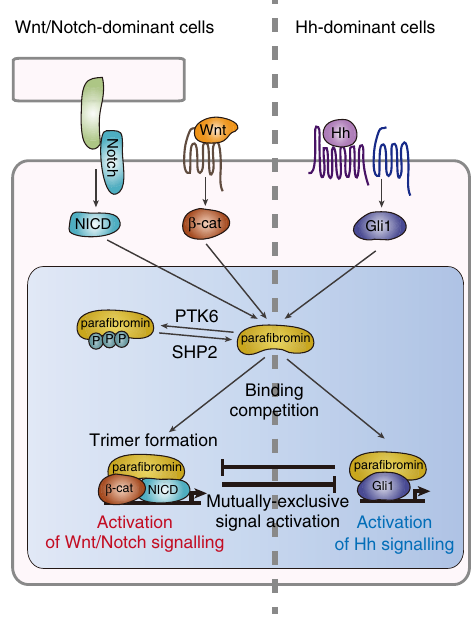
Figure 8 | A schematic diagram showing parafibromin-mediated signal coordination. Signal inputs and outputs of the Wnt, Hh and Notch signals are coordinated intracellularly by parafibromin, which acts as a transcriptional platform/scaffold. Depending on its cellular context, parafibromin competitively interacts with b -catenin or Gli1, thereby activating Wnt and Hh signals in a mutually exclusive manner. On the other hand, parafibromin forms a heterotrimeric complex with b -catenin and Notch intracellular domain (NICD), supporting concerted activation of Wnt and Notch signals. This platform function of parafibromin is inversely regulated by parafibromin tyrosine phosphorylation and dephosphorylation, which are mediated by PTK6 and SHP2,